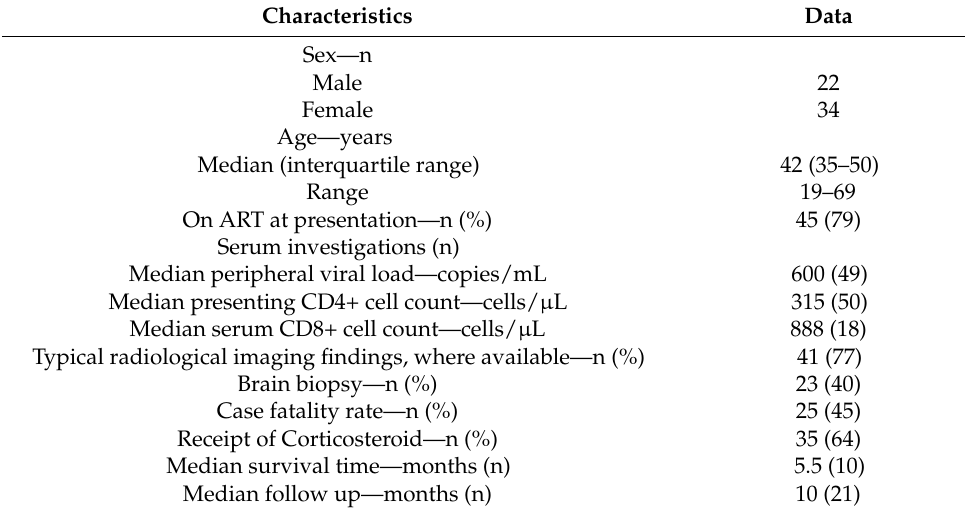
Table 3. Summary characteristics of patients ( n =